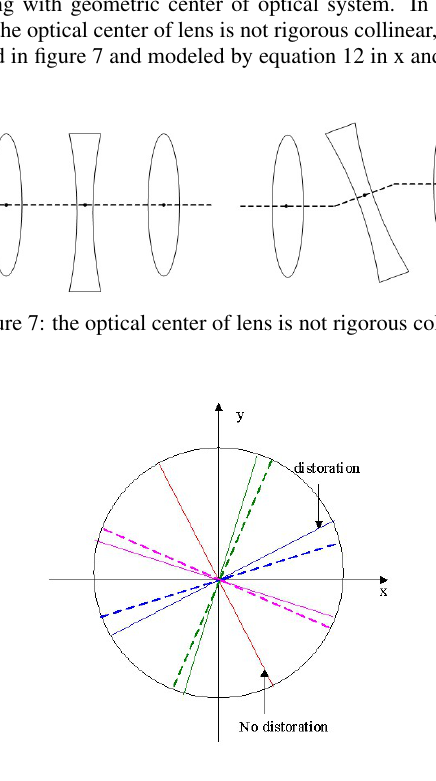
Figure 8: Tangential